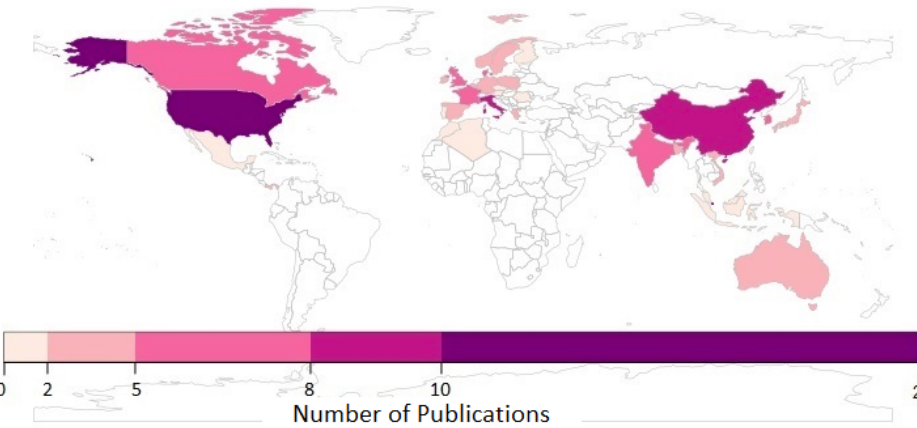
Figure 4. Publications on indoor occupancy by country.